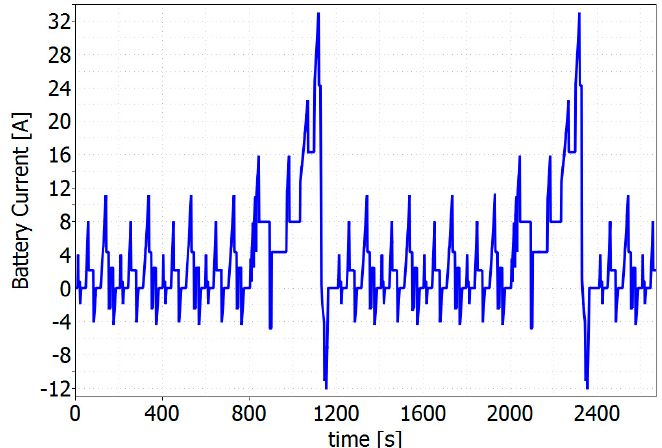
Figure 8. New European Driving Cycle (NEDC) current profile.